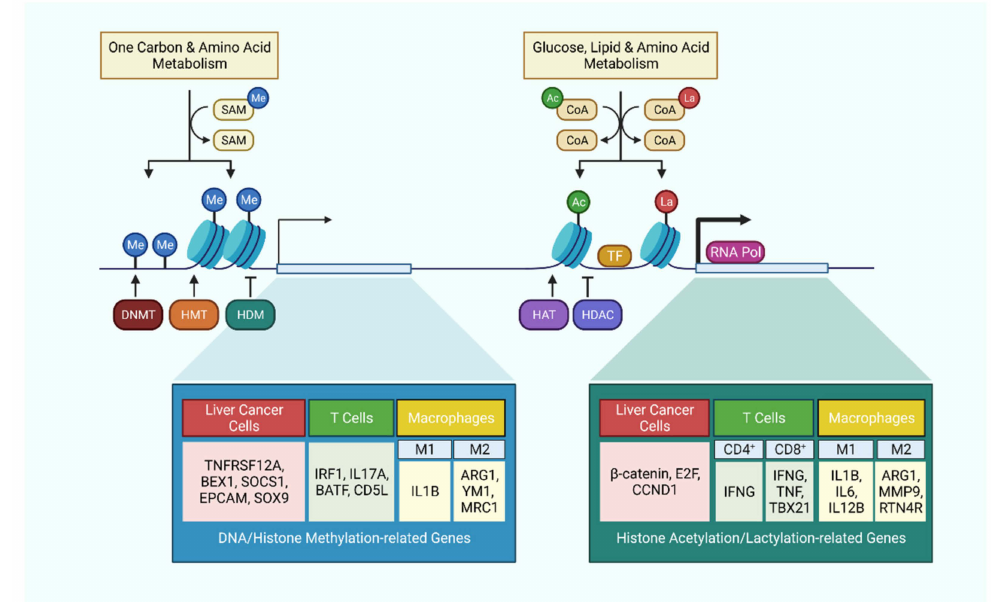
Figure 2. Metabolism-related epigenetic modifications in liver cancer cells and immune cells. Cellular metabolism tightly regulates epigenetic modifications by supplying essential substrates and